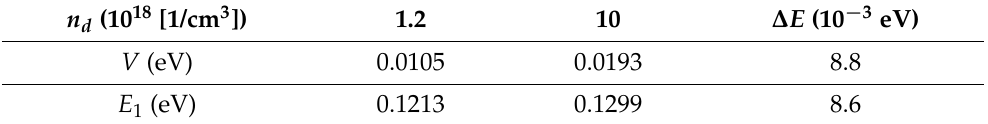
Table 1. Energy associated with the conductance peaks and potential at the center of the well and their differences ∆ E for the two calculated concentrations, the data correspond to Figure 8.